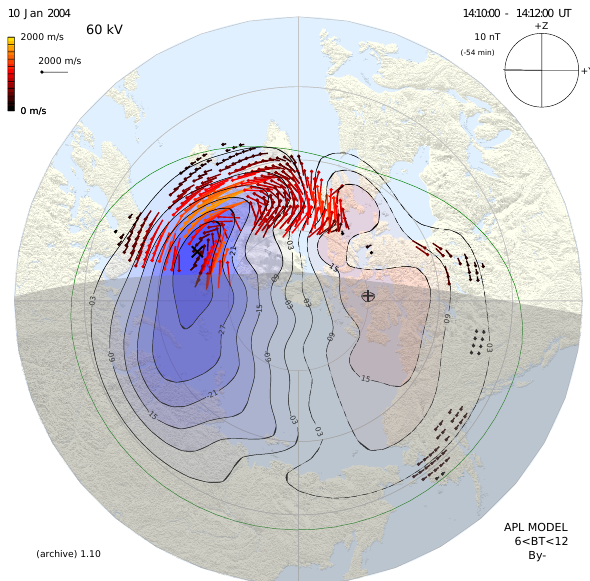
Fig. 4. Spatial plot of plasma convection obtained by SuperDARN radars during the 2-min scan at 14:10–14:12UT. The coordinate system is MLT/MLAT. The terminator is marked in the